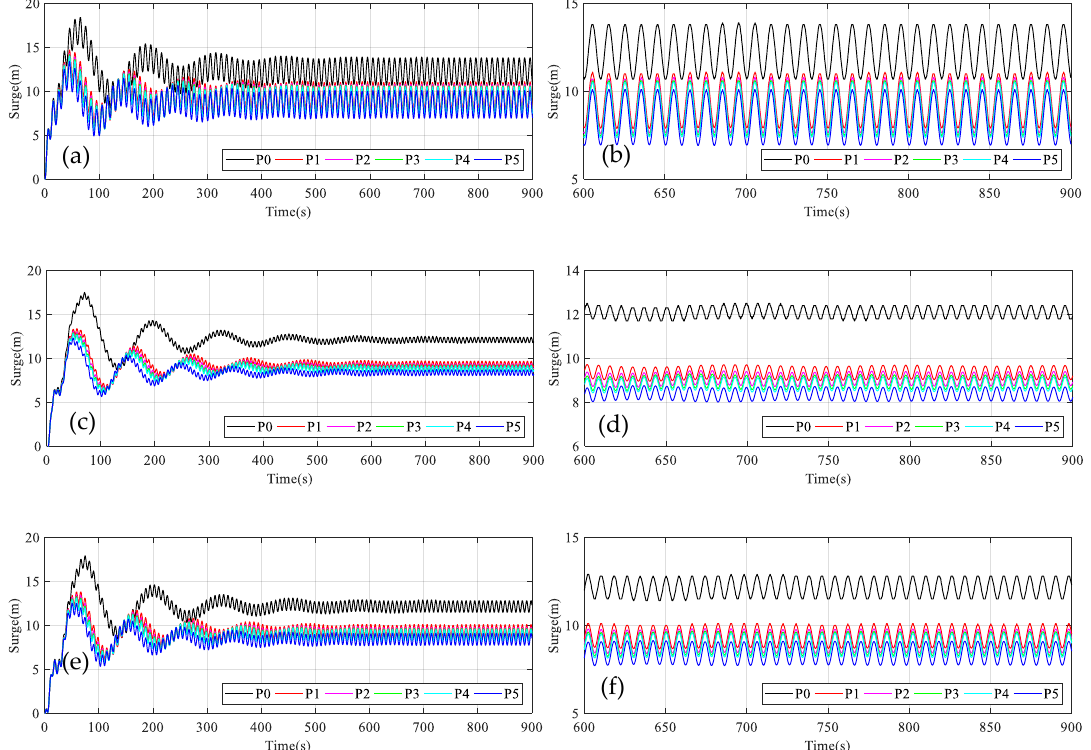
Figure 5. Surge motion from 0 s to 900 s for ( a ) case 1, ( c ) case 2, and ( e ) case 3, and from 600 s to 900 s for ( b ) case 1, ( d ) case 2, and ( f ) case 3.